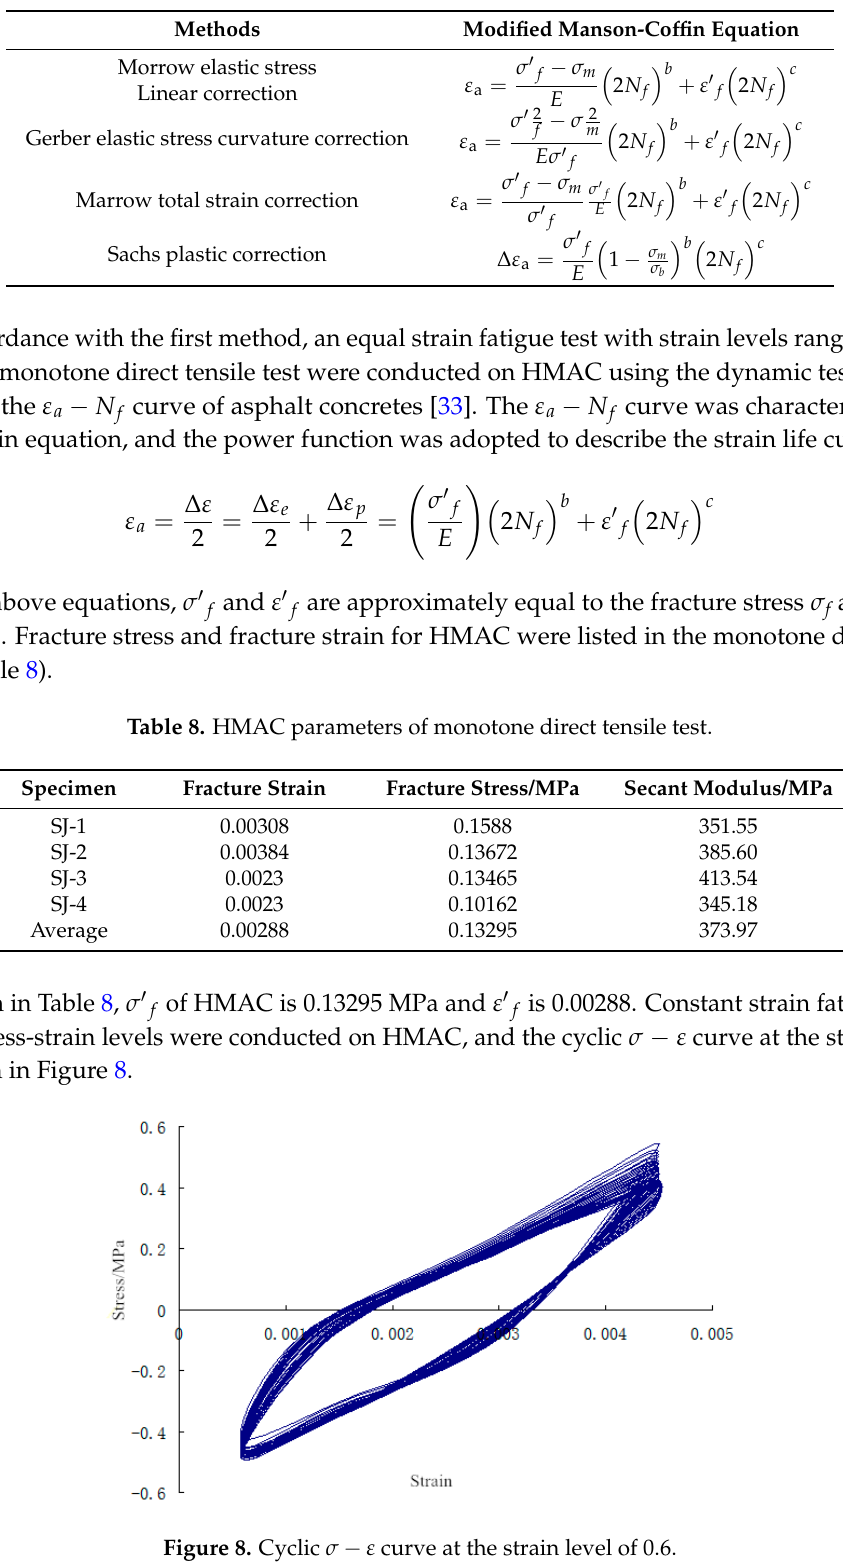
Table 9. Strain amplitude and fatigue life of HMAC in equal strain fatigue test.